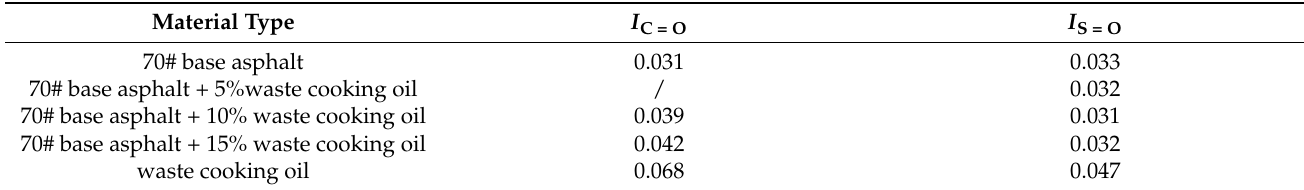
Table 5. Calculation results of sulfoxide index and carbonyl index [17].